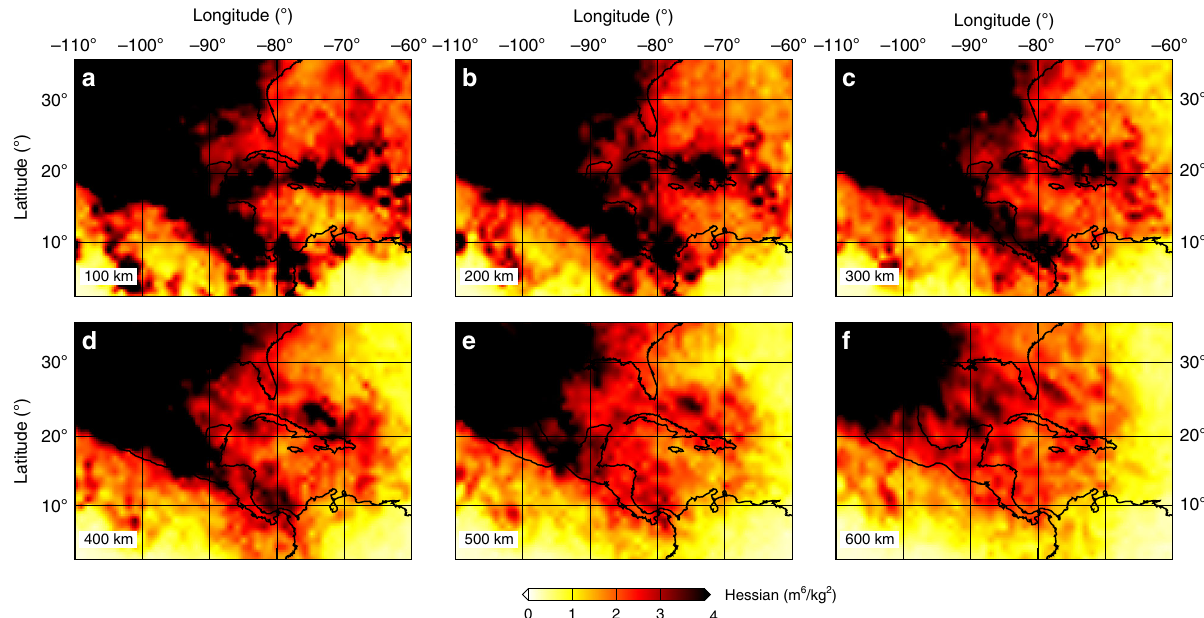
Fig. 3 The distribution of the approximated diagonal Hessian for the study region. a – f Results at depths ranging from 100 to 600 km. Warm color represents good illumination in comparison to cool